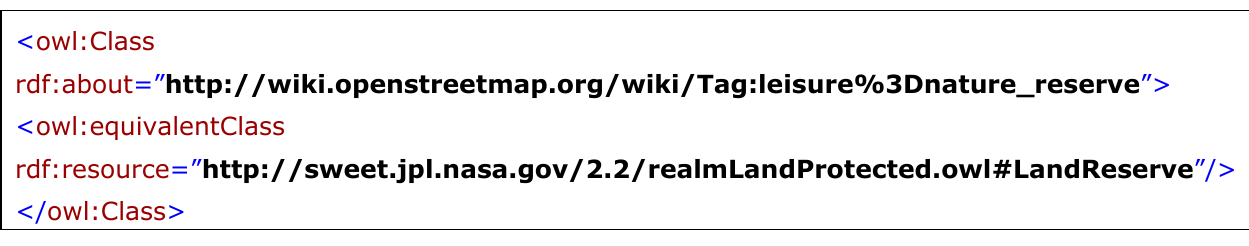
Figure 9. Example Registration Mapping from OSM feature class to SWEET ontology class.